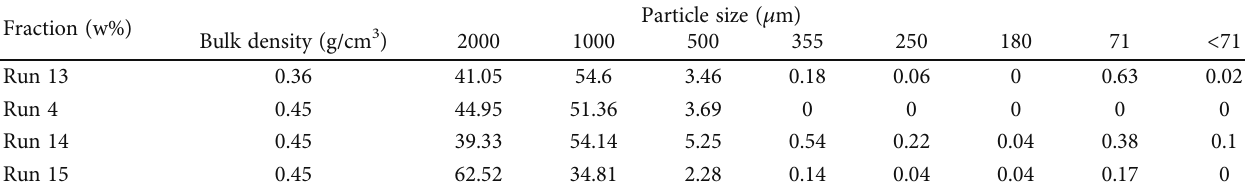
Table 3: PSD for polymer produced at varied prepolymerization